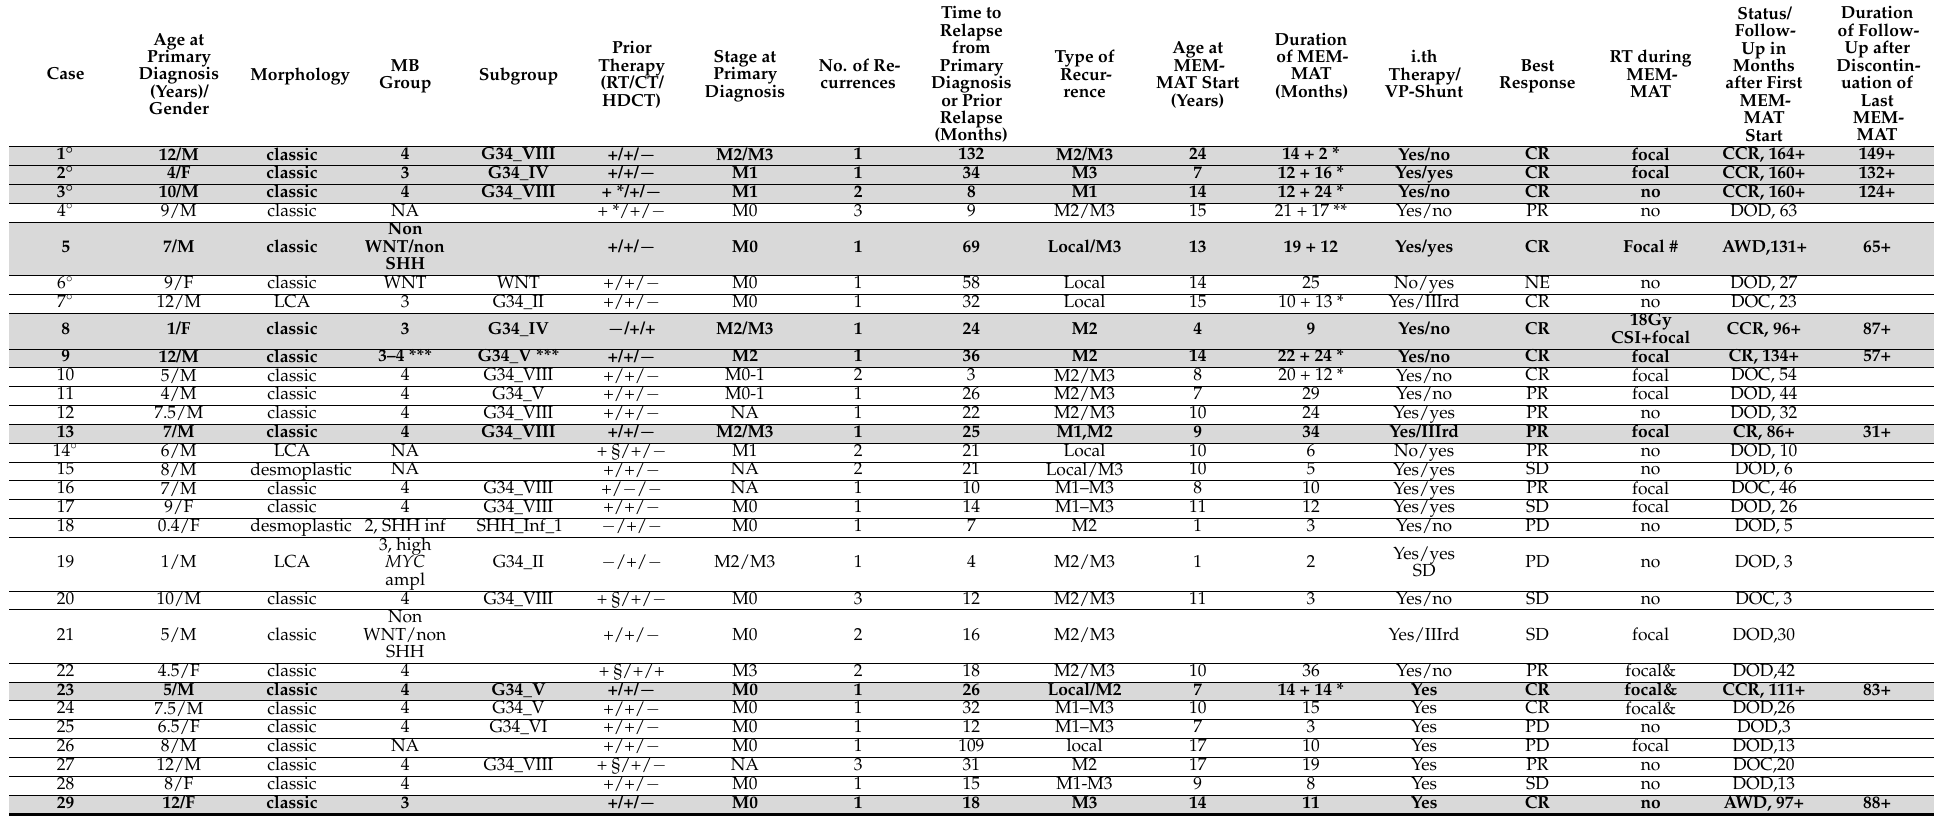
Table 1. Clinical characteristics, molecular tumor profile, and outcome of patients with medulloblastoma